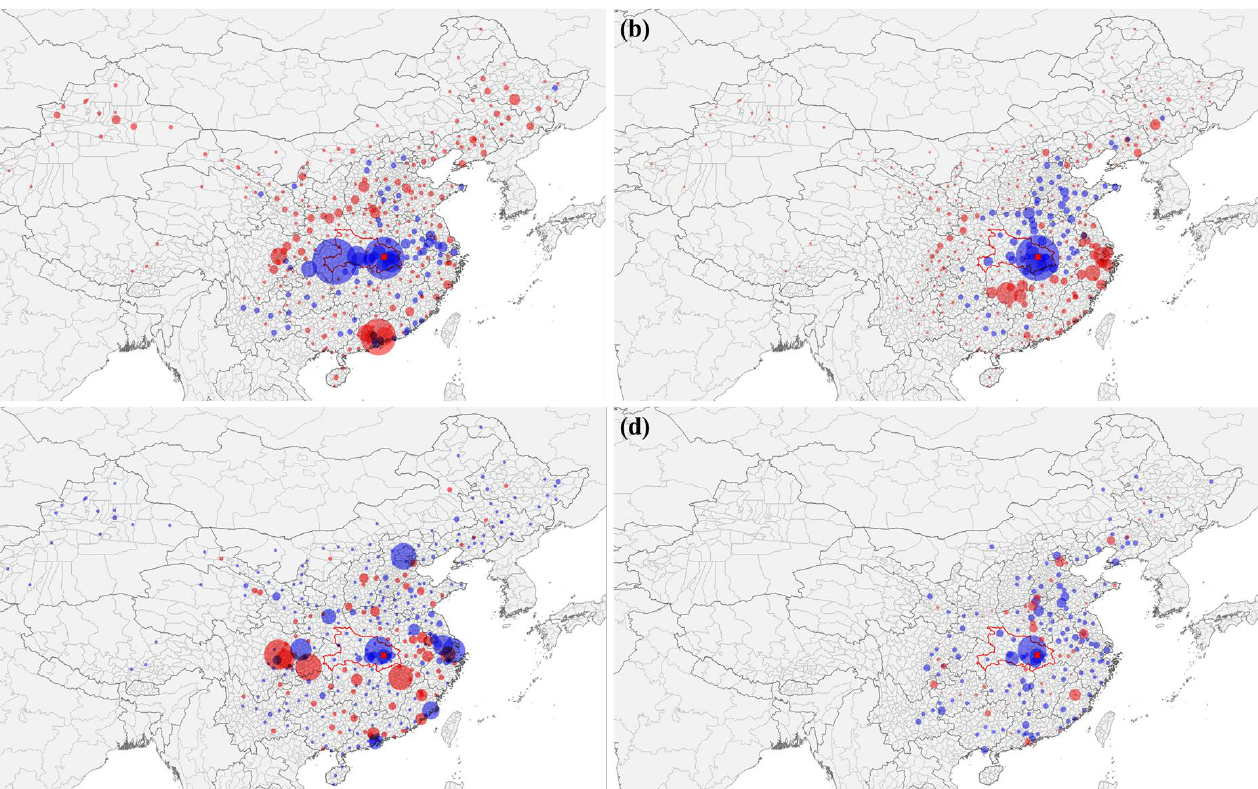
Figure 2. The changes in train frequency in the OD network after the Wuhan city lockdown at the city and province levels, where ( a ) D-series and ( b ) G-series high-speed trains are shown at the city scale. Blue represents decreased train frequency, and red represents increased frequency. The longitudinal railway is the Jingguang railway (green line), and the widthwise railway is the Shanghai–Wuhan–Chengdu railway (green line). The province-level changes for the ( c ) D-series and ( d ) G-series high-speed trains are shown to identify the routes most affected by the Wuhan city lockdown.